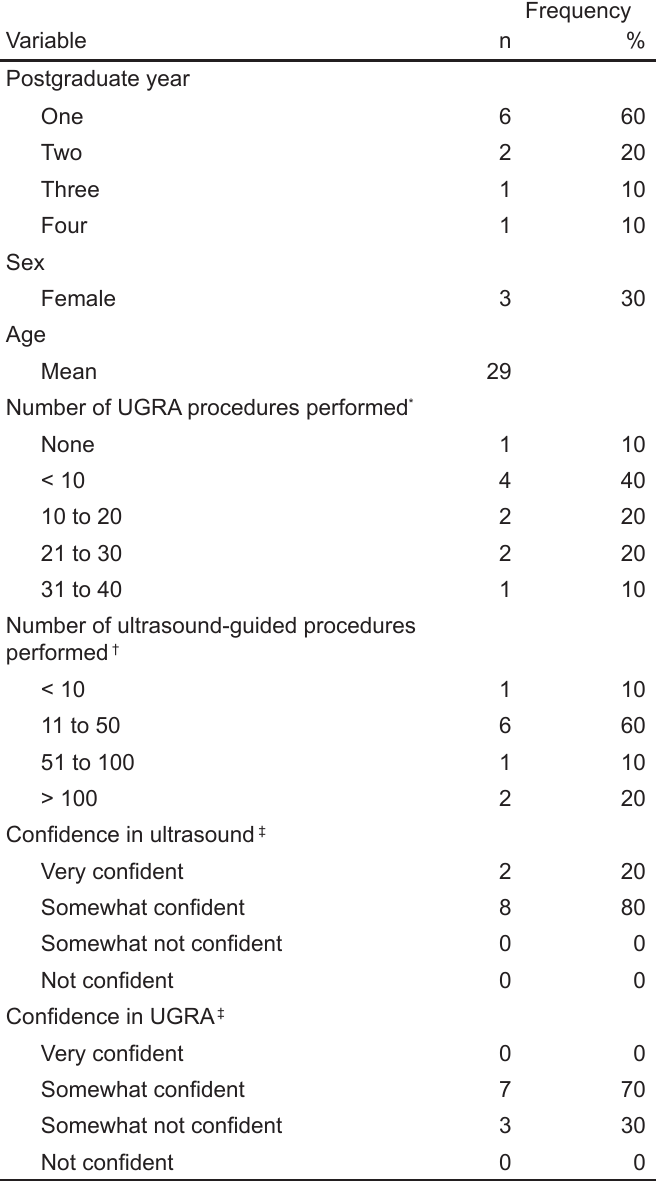
Table 1. Demographics and self-reported ultrasound proficiency of enrolled emergency medicine residents.